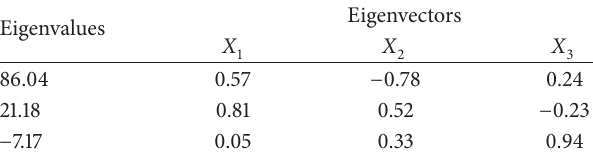
Table 7: Eigenvalues and